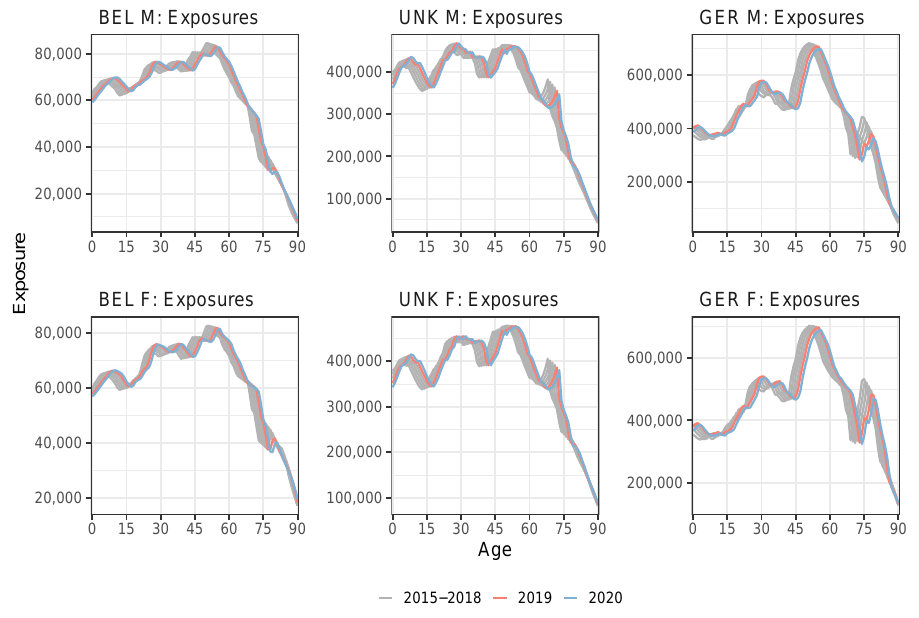
Figure 3. (Virtual) annual exposures E x , t for males ( top ) and females ( bottom ) in Belgium ( left ), the United Kingdom ( middle ) and Germany ( right ) as a function of age, years 2015–2020. Exposures for the years 2015–2019 (Belgium), 2015–2018 (United Kingdom) and 2015–2019 (Germany) are directly available from the HMD or Eurostat. However, for the year 2020 (Belgium and Germany) and the years 2019–2020 (United Kingdom), we transform the weekly exposures collected in age buckets from the STMF data series to exposures at individual